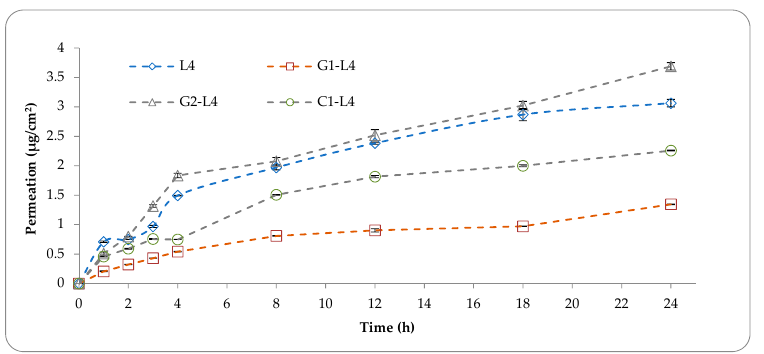
Figure 3. In vitro permeation profiles (µg/cm 2 ) of 5-FU across Strat-M membrane in phosphate buffer solution (pH 7.4) from topical formulations with drug loaded liposomes. Synthetic membranes for in vitro permeation studies were originally developed to be used as an alternative to animal or human skin models. Some advantages of using a syn- thetic membrane are: controlled membrane thickness, faster membrane preparation time, low storage space and relatively low cost [44]. In this study, 5-FU-loaded aptamer func- tionalized liposomes were incorporated in gel/cream formulations and tested in order to demonstrate the potential applicability in cancer treatment. As can be observed from the Figure 3, the permeability of 5-FU decreased when the drug-loaded functionalized liposomes are incorporated into G1 and C1 formulations and increase when are incorporated into G2